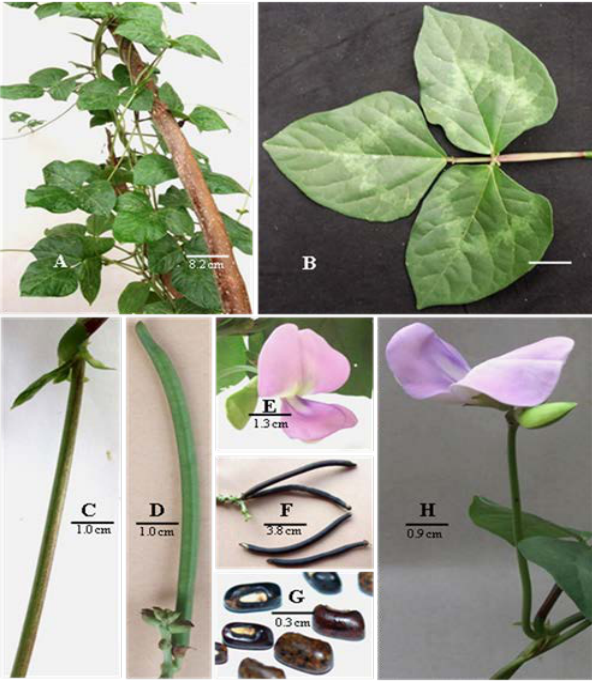
Fig. 7. Morphology of Crotalaria retusa :Linn. A. Habit (shrub), B. Leaf, C. Stem, D. Inflorescence (terminal raceme), E. Flower (arrow points at reddish-brown veining on the standard alone), F. Fruit (fresh), G. Fruit (dry), H. Seeds